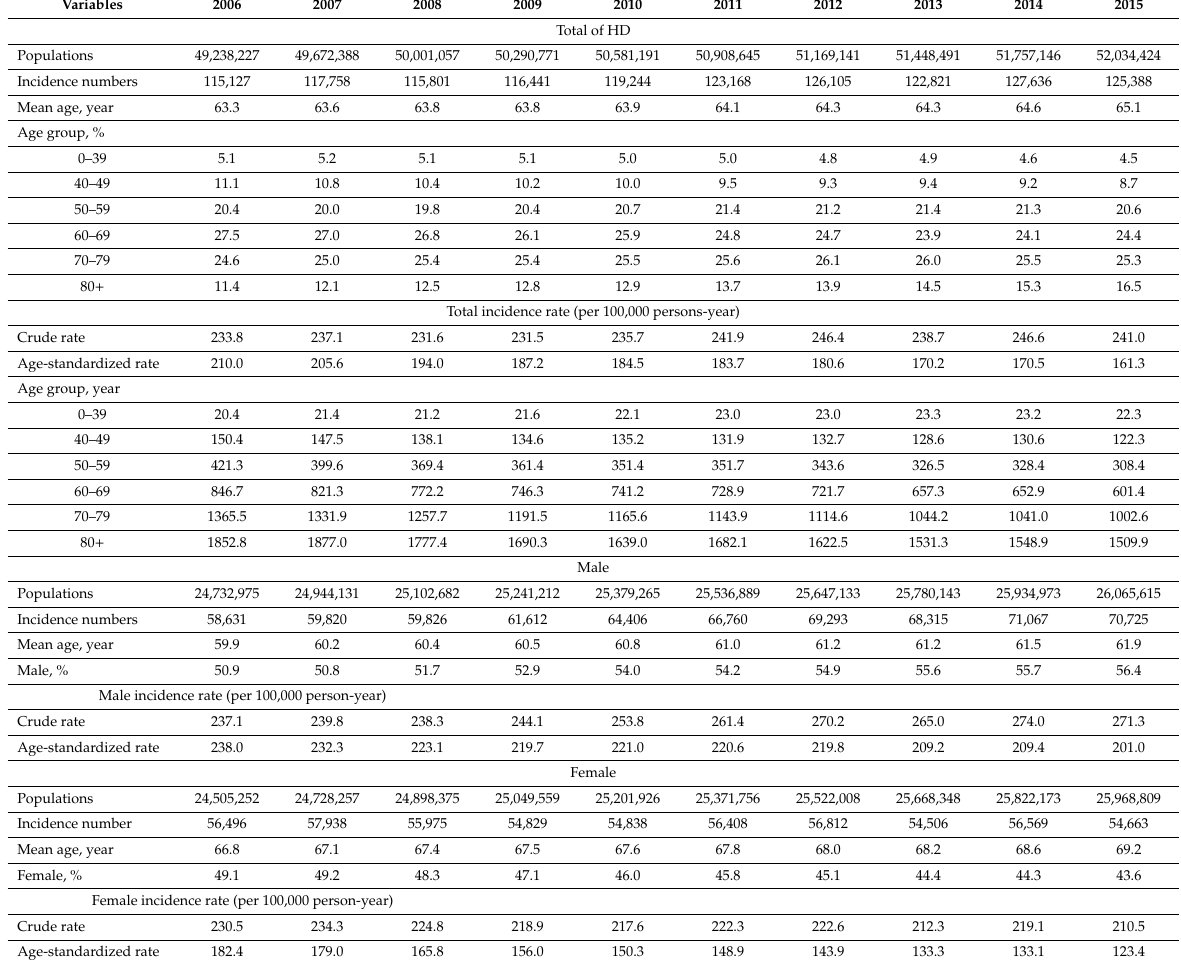
Table 1. Annual numbers and incidence rates of HD in Korea,